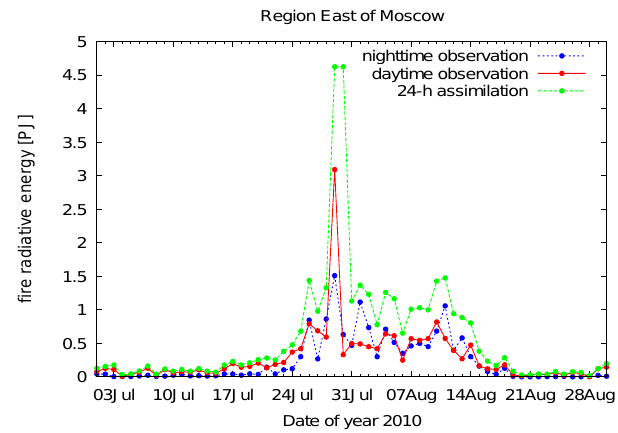
Fig. 10. Daily FRE observed during daytime and night-time east of Moscow, along with assimilated FRE, for July and August 2010.